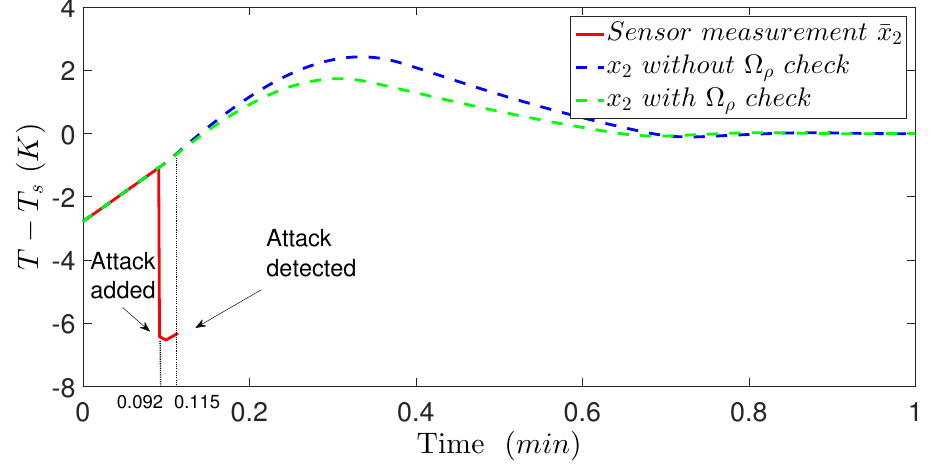
Figure 12. Closed-loop state profiles ( x 2 = T − T s , ¯ x 2 = ¯ T − T s ) for the initial condition (0.24, − 2.78) under the LMPC of Equation (14) and the NN-based detection